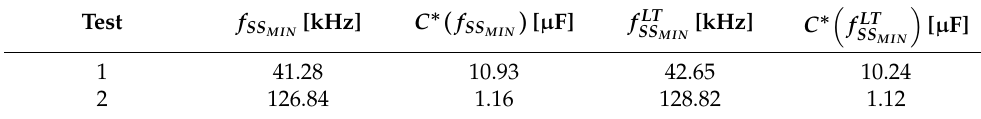
from analysis, f LT from SS MIN MIN